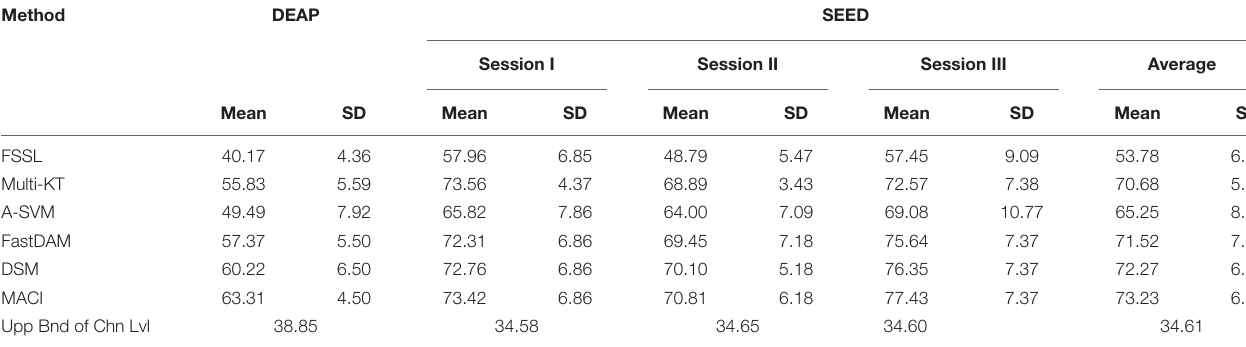
TABLE 2 | Emotion recognition performance (mean % and SD %) of MACI and several baselines on within-datasets. Method DEAP SEED Session I Session II Session III